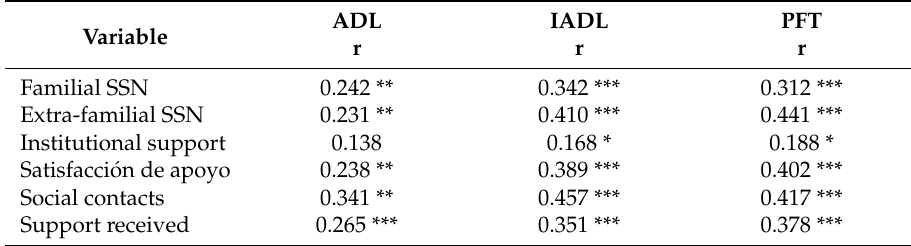
Table 5. Correlation between social support networks for older people (SSN-Older) scores and scores for ADL, IADL and